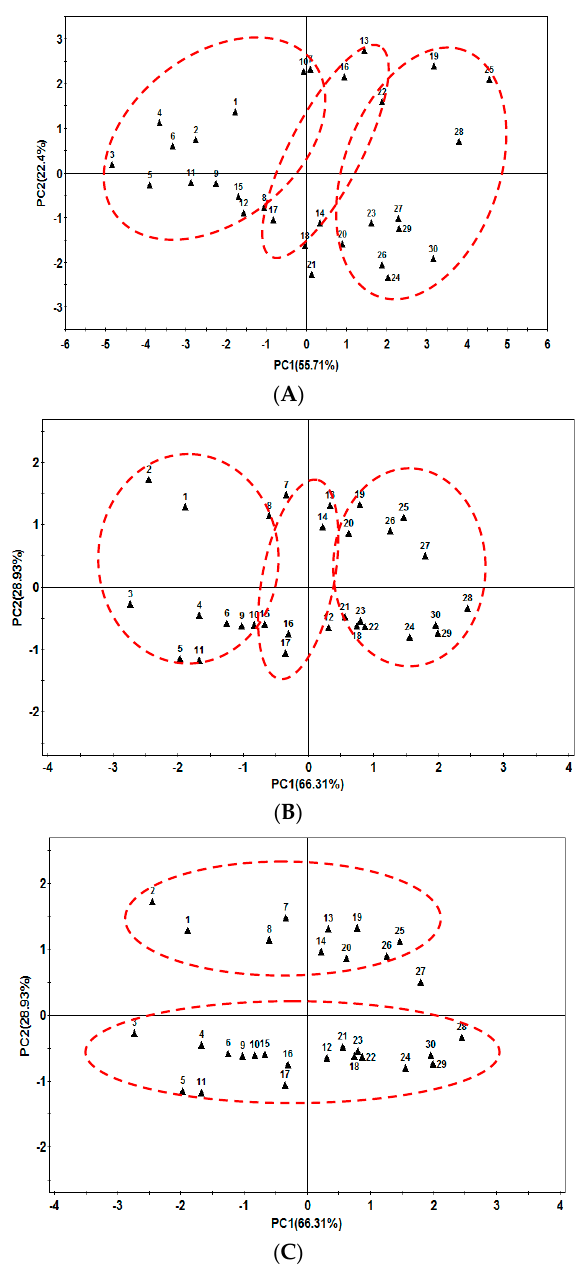
Figure 6. HPLC-principal component analysis (PCA) of Panax ginseng root. ( A ) Two-dimensional diagrams of PCA1 and PCA2, using contents of 11 saponins as input data; ( B , C ) Two-dimensional diagrams of PCA1 and PCA2, using contents of ginsenosides Ro, Rg 1 and Re as input